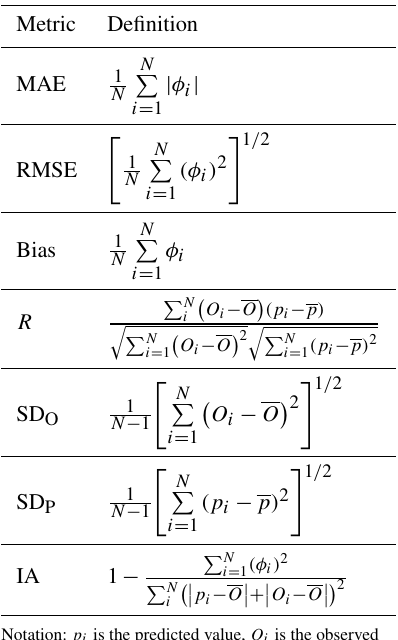
Table 1. The definition of evaluation metrics of the model. Table 2. The best hyperparameters of the